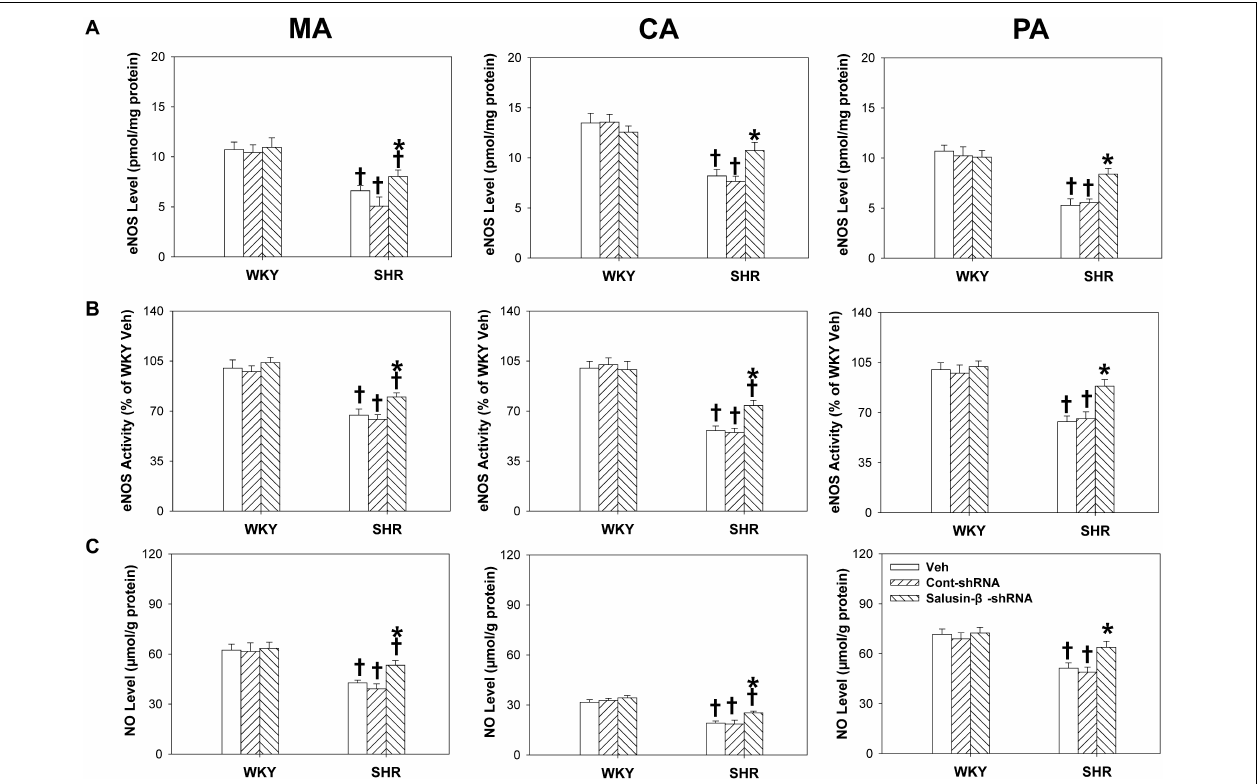
FIGURE 7 | The effects of salusin- β knockdown on eNOS level (A) , eNOS activity (B) and NO level (C) of MA, CA, and PA in WKY and SHR. Two-way ANOVA was used for data analysis, followed by Bonferrioni post hoc test to compare with the multiple groups. Values are mean ± SE. ∗ P < 0.05 compared with Veh or Cont-shRNA, † P < 0.05 compared with WKY. n = 6 for each group.